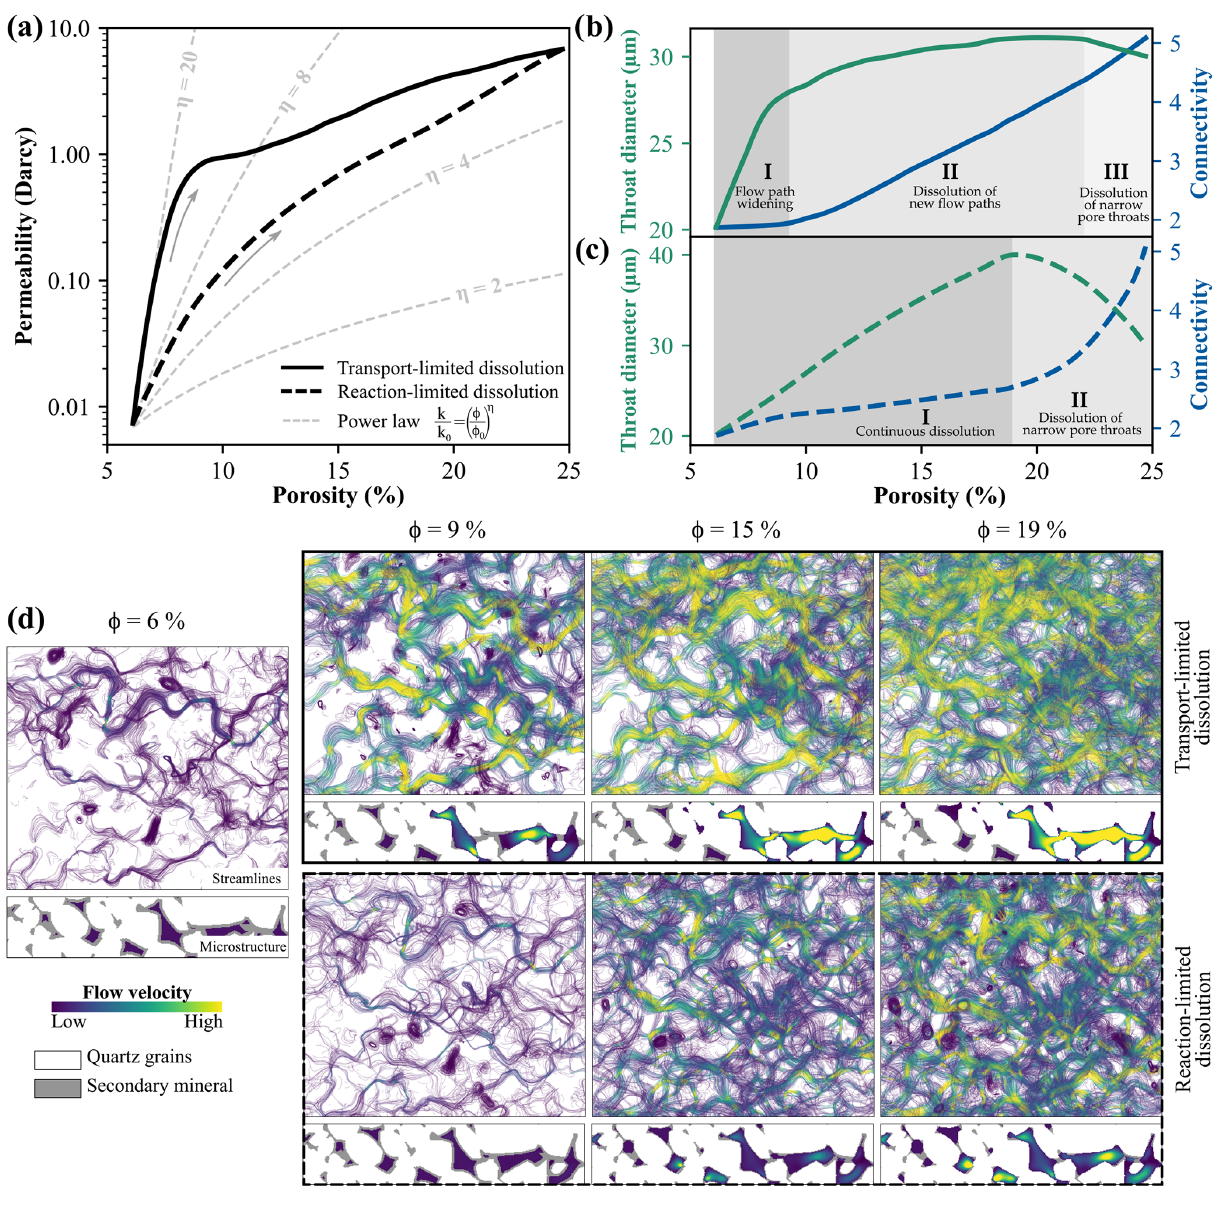
Figure 4. (a) Simulated porosity-permeability trends for reaction- and transport-limited dissolution compared to analytical power law rela- tions with different exponents ( η ). Evolution of median throat diameter and mean connectivity for the (b) transport- and (c) reaction-limited regimes with phases of characteristic morphometric evolution. (d) Differences in the flow field between both dissolution regimes represented by streamlines ( x – y projection of the 3D sample) as well as the microstructure (2D